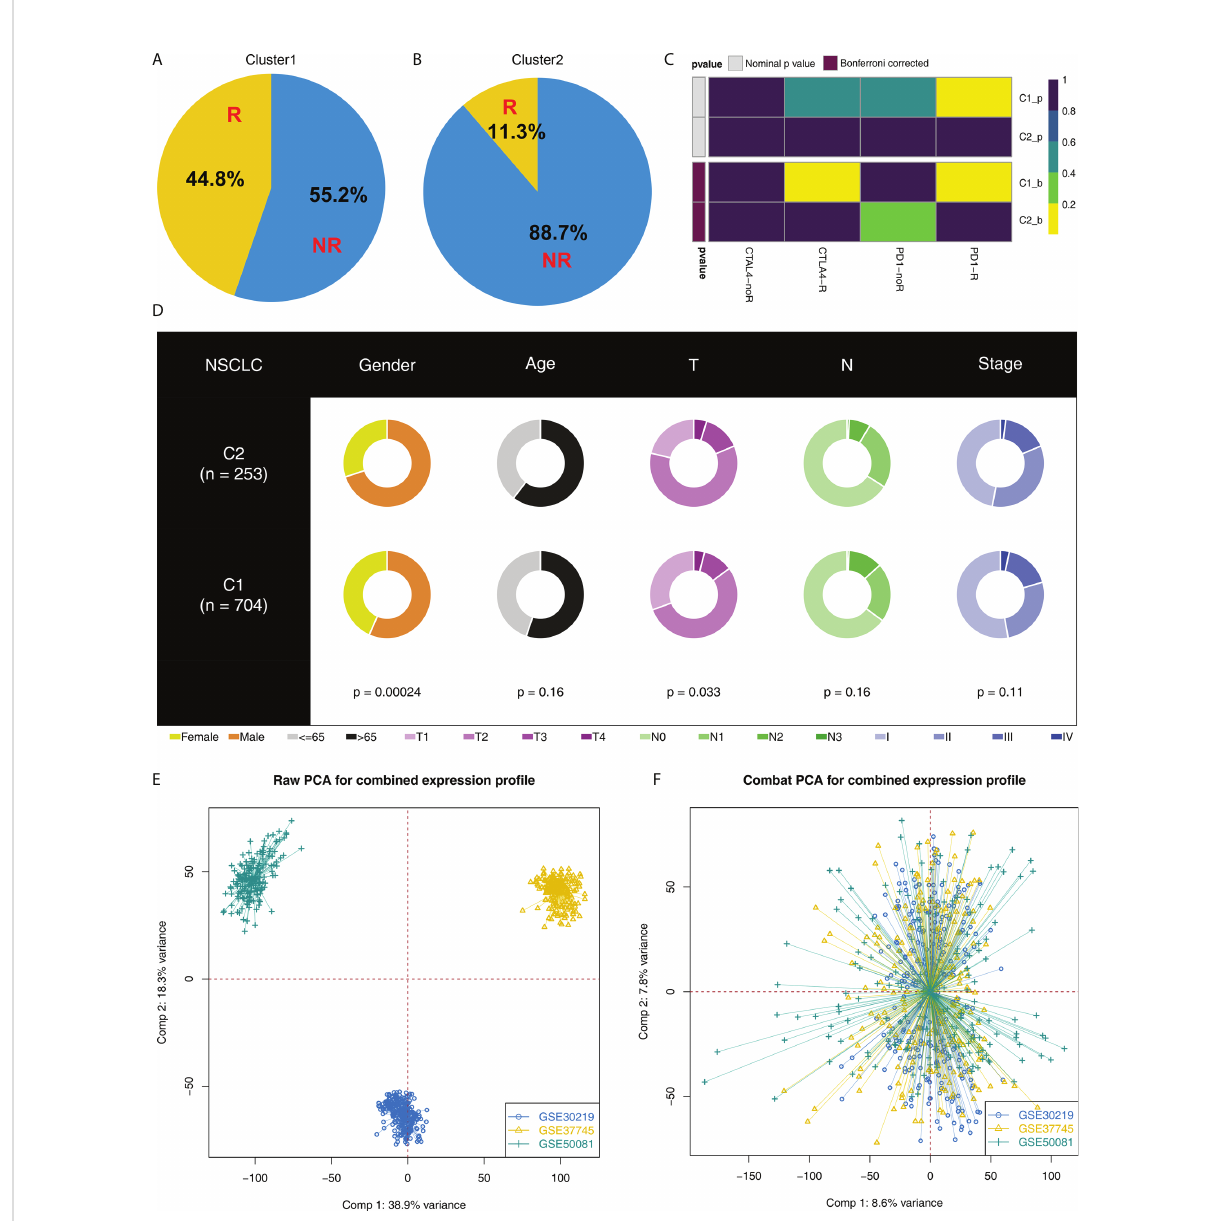
FIGURE 3 Cluster1 and Cluster2 had different immunotherapy response. (A, B) The proportion of immunotherapy responders in Cluster1 and Cluster2 patients; (C) Submap algorithm indicated that the Cluster1 patients are sensitive to both PD-1 and CTLA4 therapy; (D) Clinical features difference in Cluster1 and Cluster2 patients; (E, F) Sva package was used for data combination and batch effect reduction of GSE30219, GSE37745 and